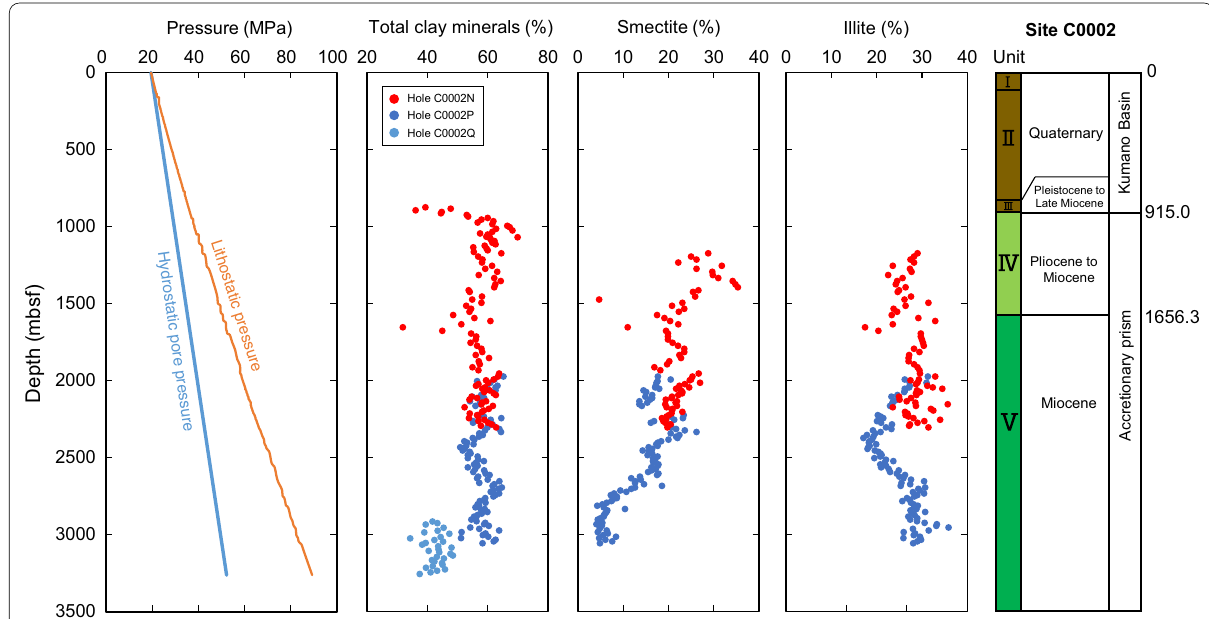
Fig. 2 Pressure, clay mineral content, and unit classification profiles for Site C0002 (after Tobin et al. 2015, 2020; Underwood 2017a, b; Kitajima et al. 2020). The lithospheric pressure is calculated from the overburden stress, which is derived from the rock density, and the hydrostatic pore pressure is calculated using a fluid density of 1.024 g/cm